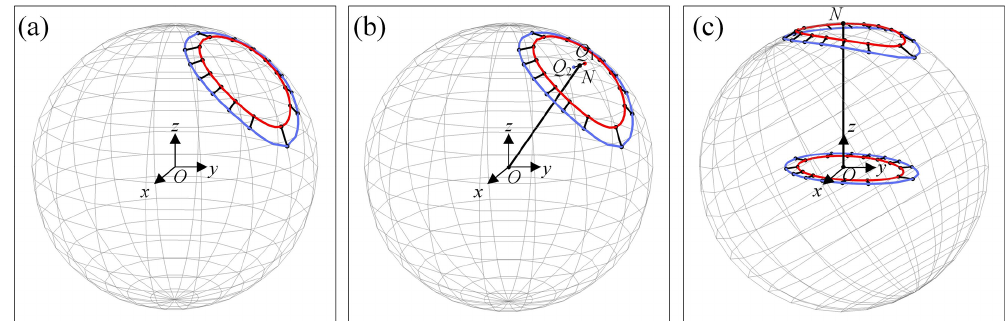
Figure 5. Schematic graph of the preprocessing.